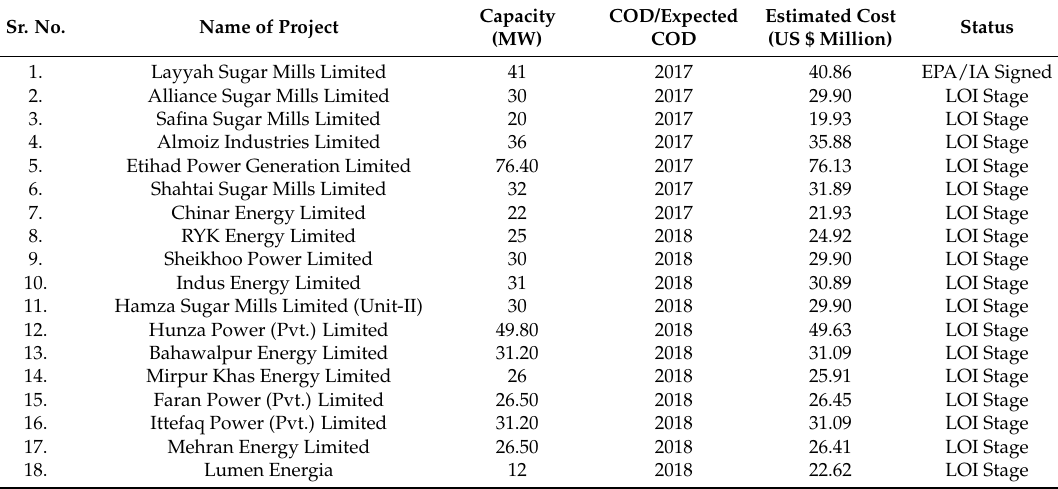
Table 20. Future biomass/bagasse-based